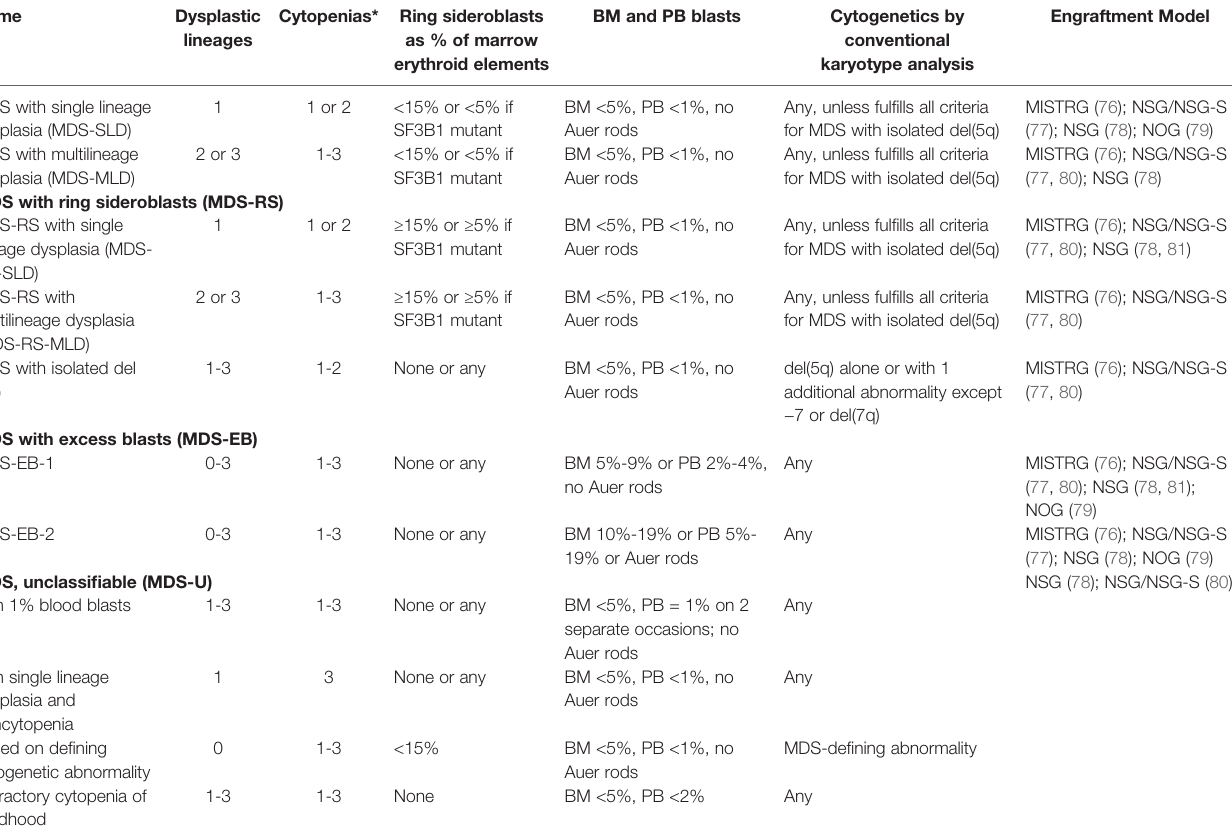
TABLE 2 | PDX mouse models of